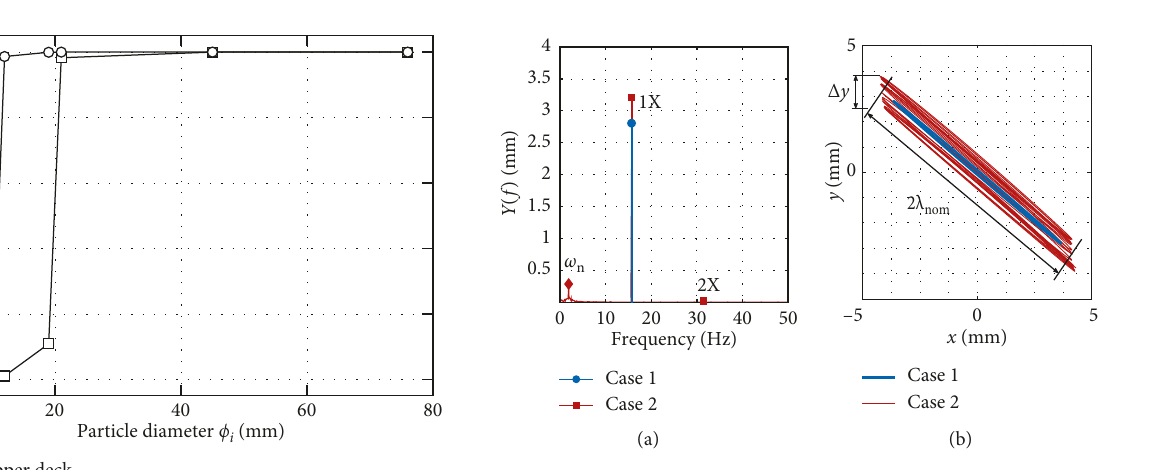
Figure 9: Comparison of the movement of support A in cases 1 and 2: (a) frequency spectrum and (b)